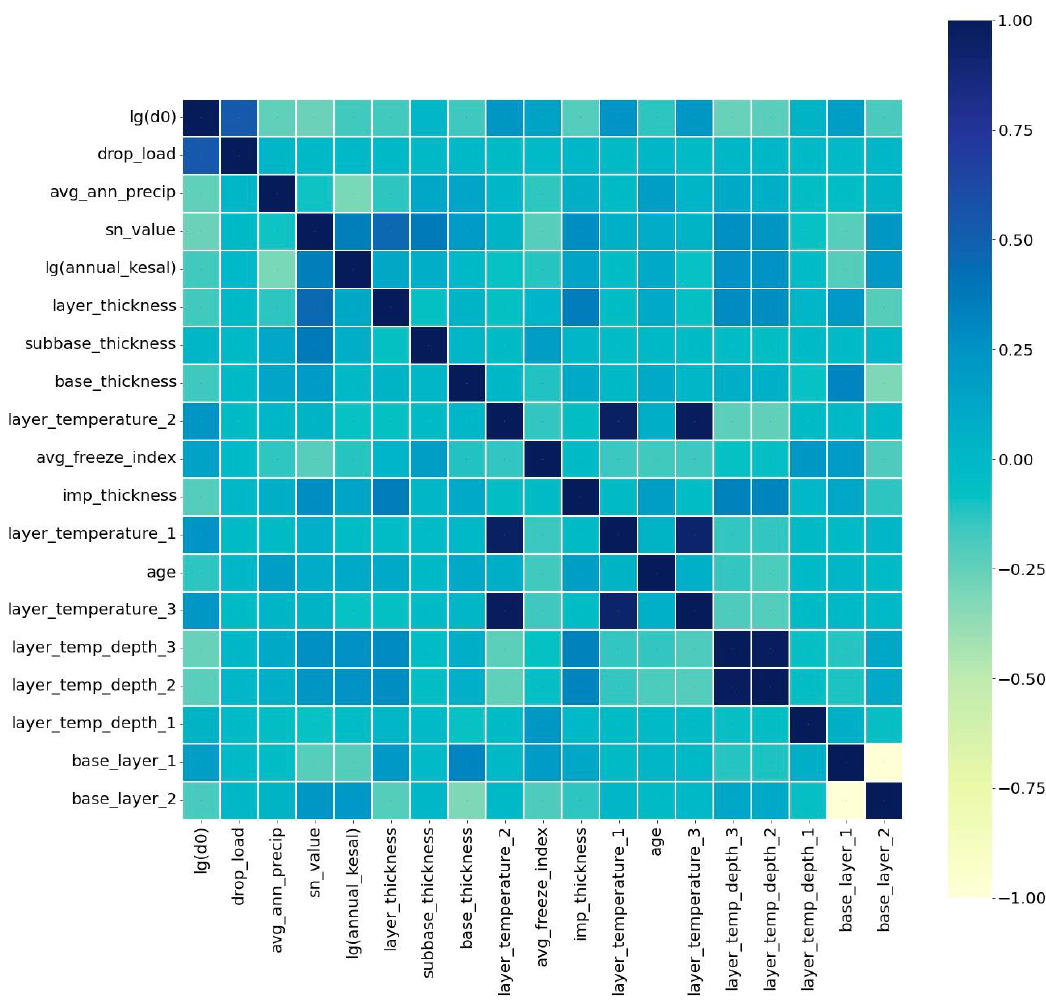
Figure 1. Pearson ’s correlation coefficient of features. Figure 1. Pearson’s correlation coefficient of